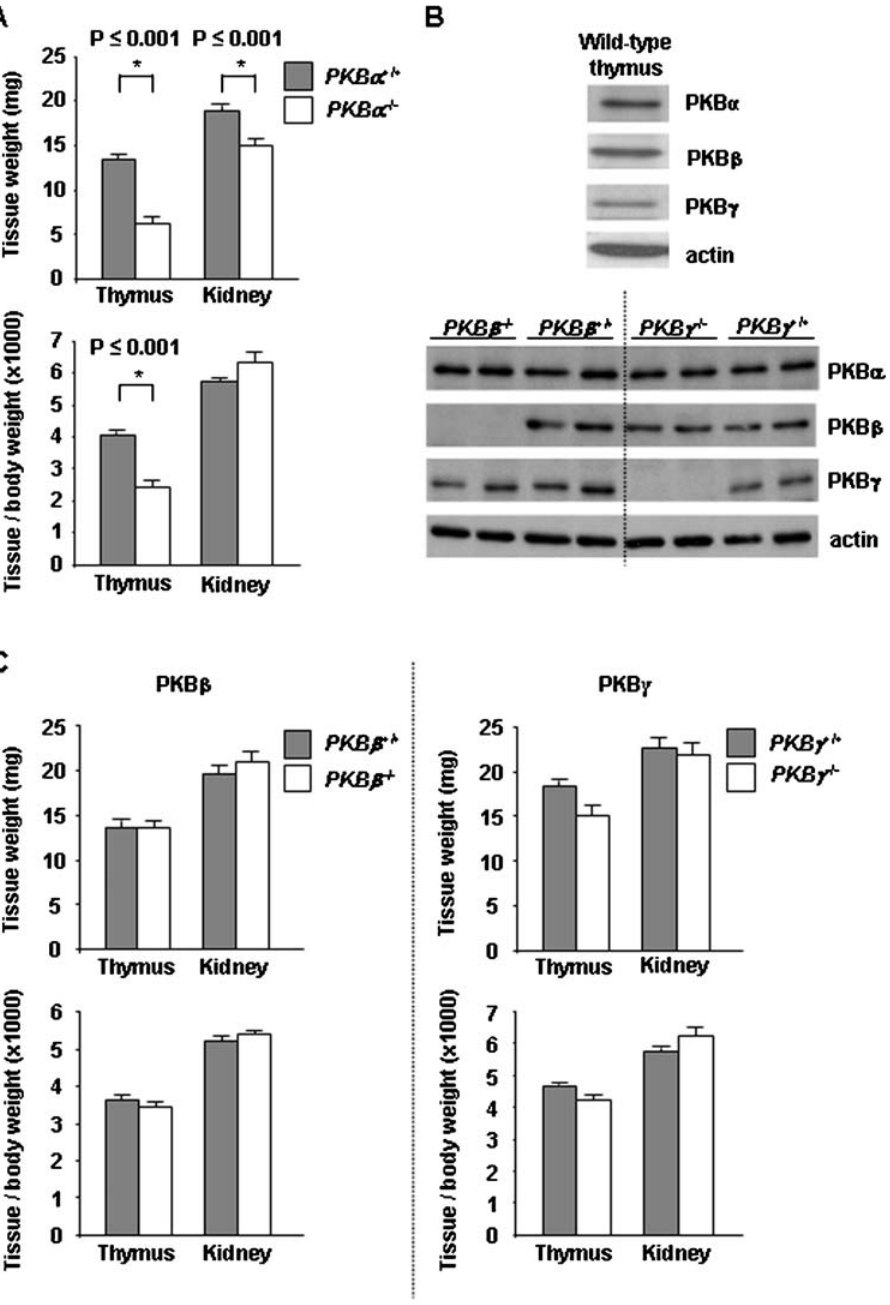
Figure 1. The deletion of PKB a leads to a reduced thymic size in mouse neonates. A: The weight of freshly dissected thymi was measured in PKB a + / + and PKB a 2 / 2 neonates (top panel) and expressed as ratio to body weight (bottom panel). The kidney was used as a control. Error bars represent standard error of the mean; n $ 13. B: Western-blot analysis of 50 m g protein extracts from wild-type neonatal thymus using PKB isoform specific antibodies (top panel). Western-blot analysis of 50 m g protein extracts from PKB b 2 / 2 , PKB b + / + , PKB c 2 / 2 , and PKB c + / + neonatal thymi using PKB isoform specific antibodies (bottom panel). Actin was used as a loading control. C: The weight of freshly dissected thymi was measured in PKB b + / + , PKB b 2 / 2 , PKB c + / + , and PKB c 2 / 2 neonates (top panels) and expressed as ratio to body weight (bottom panels). The kidney was used as a control. Error bars represent standard error of the mean. n $ 7 (n=number of mice analyzed per genotype).